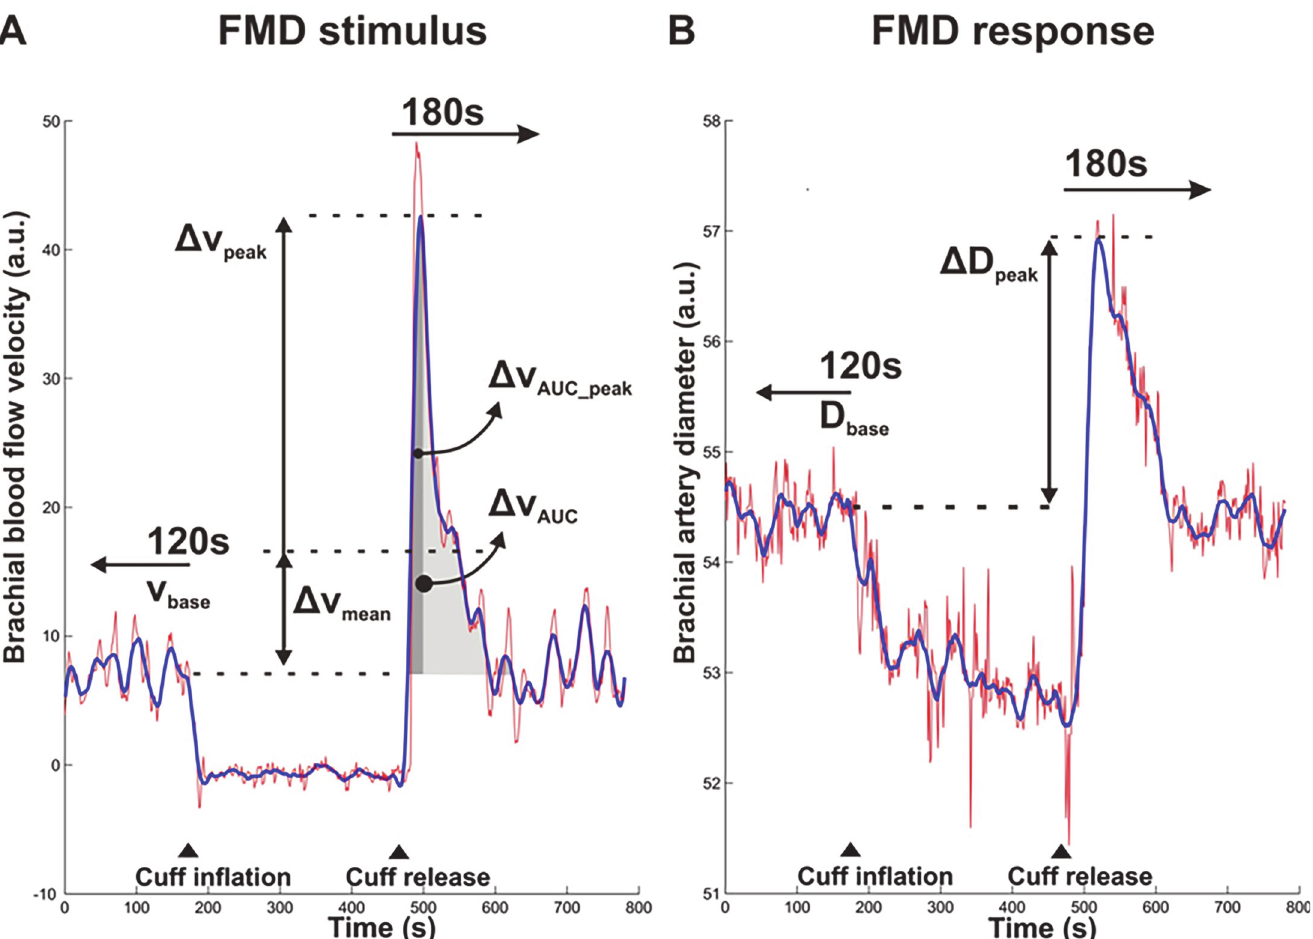
Figure 1. Definitions of baseline and hyperemic brachial artery blood flow velocity and diameter parameters for the assessment of flow-mediated dilation. Blood flow velocity (A) and diameter curves (B) obtained by beat-to-beat analysis of Duplex video images. Raw data curves (red) were smoothed (blue) to reduce noise, particularly in the peak change estimates. Baseline blood flow velocity (v base ) and diameter (D base ) were determined over the 120 seconds prior to cuff-inflation. The peak change in blood flow velocity ( Δ v peak ) was determined as the maximum velocity reached within 180 seconds after cuff-release while the mean change in blood flow velocity ( Δ v mean ) was determined as the average velocity over the 180 seconds after cuff-release, both minus the baseline blood flow velocity v base (A). The peak change in diameter ( Δ D peak ) was determined as the maximum diameter reached within 180 seconds after cuff-release minus the baseline diameter D base (B). Indicated also are the full area under the curve of the hyperemic velocity curve above baseline level ( Δ v AUC ) and the area integrated till peak-time of velocity curve ( Δ v AUC_peak ). ▲ indicates the timing of rapid cuff inflation and